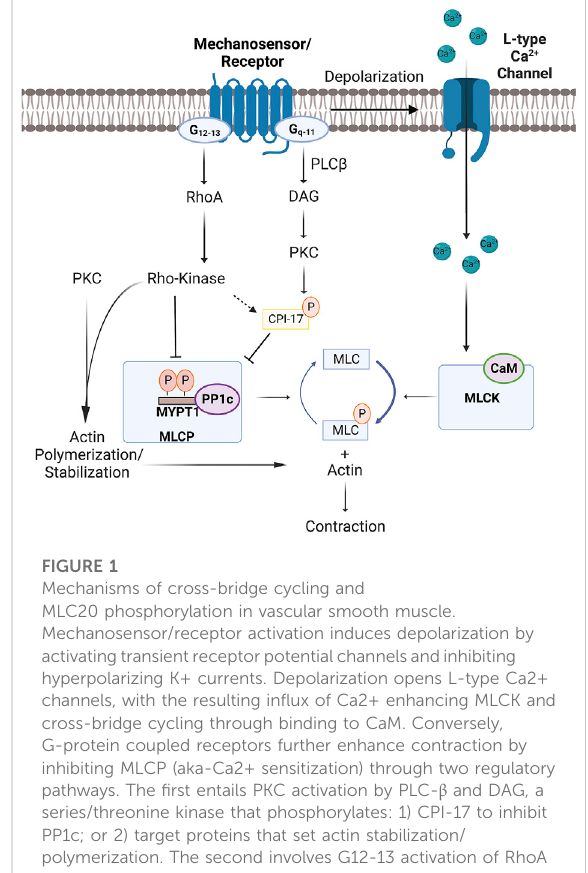
FIGURE 1 Mechanisms of cross-bridge cycling and MLC20 phosphorylation in vascular smooth muscle. Mechanosensor/receptor activation induces depolarization by activatingtransientreceptorpotentialchannelsandinhibiting hyperpolarizing K+ currents. Depolarization opens L-type Ca2+ channels, with the resulting in fl ux of Ca2+ enhancing MLCK and cross-bridge cycling through binding to CaM. Conversely, G-protein coupled receptors further enhance contraction by inhibiting MLCP (aka-Ca2+ sensitization) through two regulatory pathways. The fi rst entails PKC activation by PLC- β and DAG, a series/threonine kinase that phosphorylates: 1) CPI-17 to inhibit PP1c; or 2) target proteins that set actin stabilization/ polymerization. The second involves G12-13 activation of RhoA and Rho-kinase, the latter of which controls the phosphorylation state of: 1) MYPT1 (Threonine – 696 and Threonine – 853 (mouse numberings)); or 2) target proteins that set actin polymerization. Note, Ca2+ release from the sarcoplasmic reticulum, resulting from receptor-induced IP3 production, can also contribute to MLCK activation. Abbreviations: MLCK, Myosin light chain kinase; MLCP, Myosin light chain phosphatase, PLC, Phospholipase C; DAG, Diacylglycerol; CPI-17, Cytosolic phosphatase inhibitory protein of 17-kDa; IP3, Inositol trisphosphate; MYPT1, Myosin light chain phosphatase targeting subunit 1; MLC, Myosin